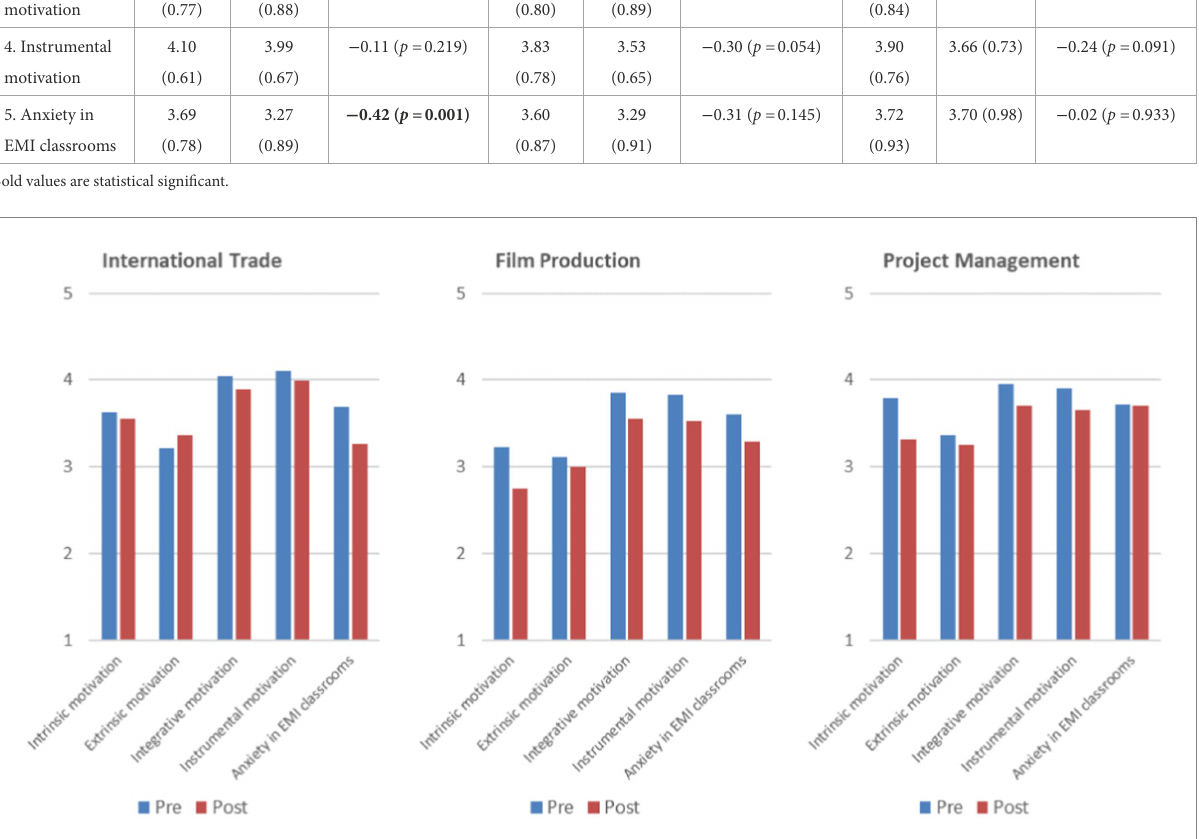
FIGURE 1 Pre-post student questionnaires (discipline